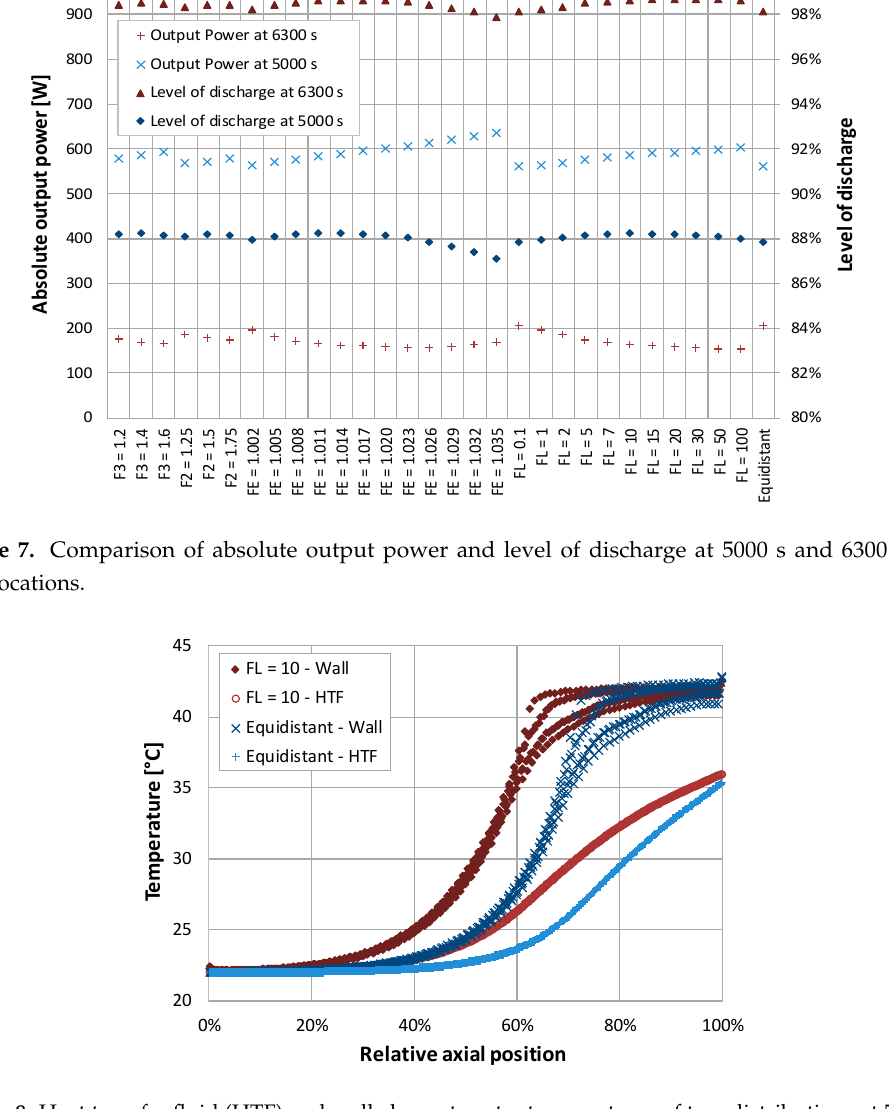
Figure 9. Heat transfer fluid (HTF) and wall element center temperatures of two distributions at 6300 s physical time.